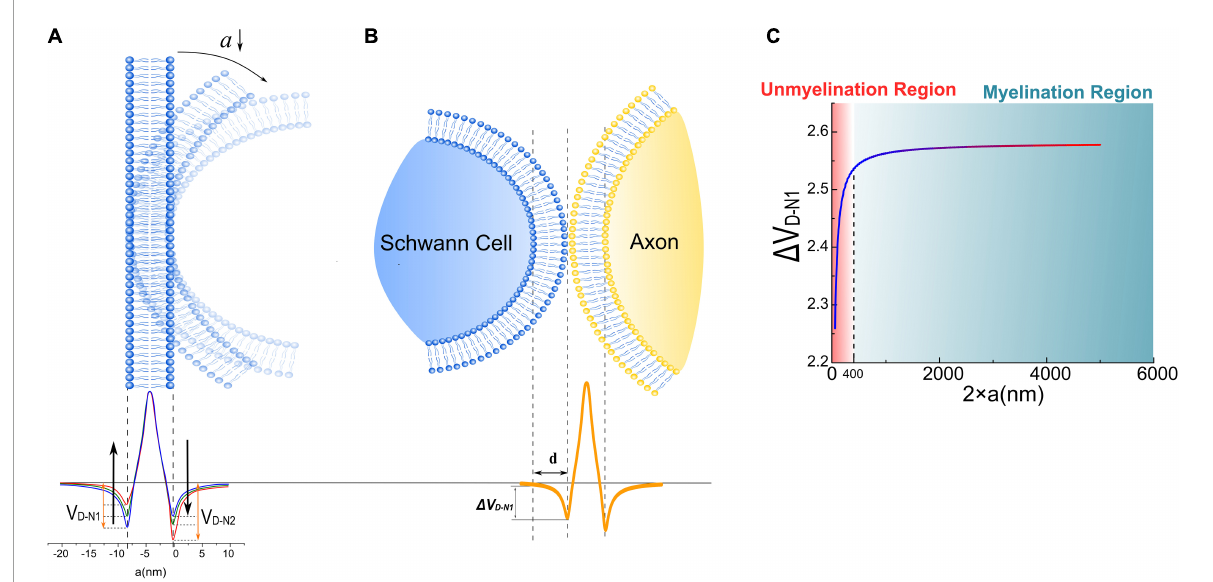
FIGURE4 (A) The dipole potential generated by the bending of the cell membrane; (B) when a Schwann cell contact with the cell membrane of an axon, a portion of the surface potential, V D − N 1 , will be exerted upon Schwann cell’s membrane, labeled as (cid:49) V D − N1 ; (C) the simulation result of (cid:49) V D − N1 is a function of axonal diameters.